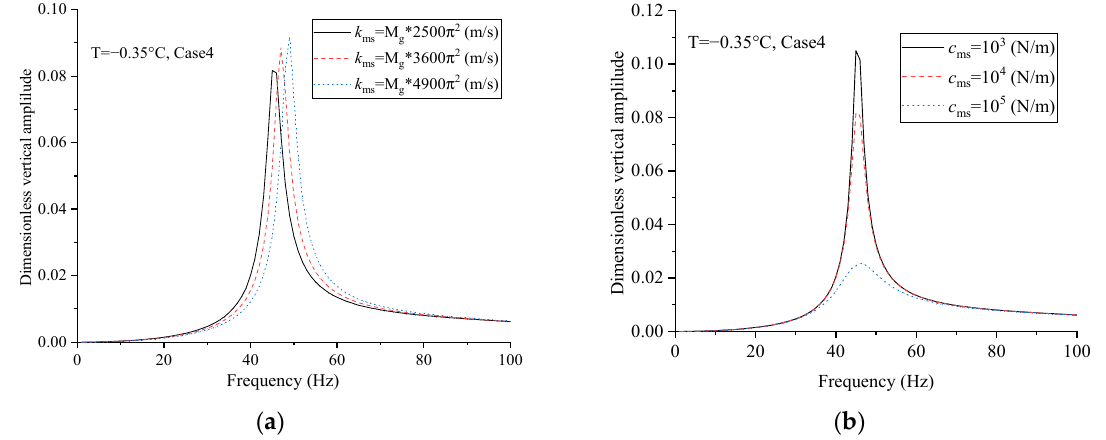
Figure 12. Effects of the support coefficients of the pile cap on the vertical amplitude–frequency